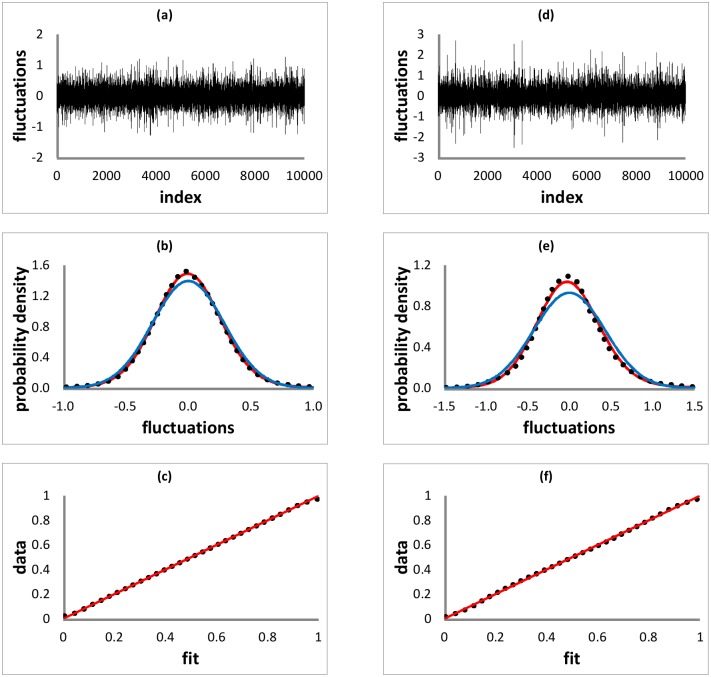
IDI fluctuation, probability density and PP plots.(a)-(c) for the experiment with pump parameter p = I/Ith = 1.0145 and threshold -1.5, (d)-(e) for the LK model simulation with pump parameter μ = 1.020 and threshold -1.0. In the density plots, the red curve is the fitted non-Gaussian stable density, the blue curve is the Gaussian density with the sample mean and variance, and the dotted curve is the smoothed data density. In the PP plots, a 45-degree red line is also drawn for reference.